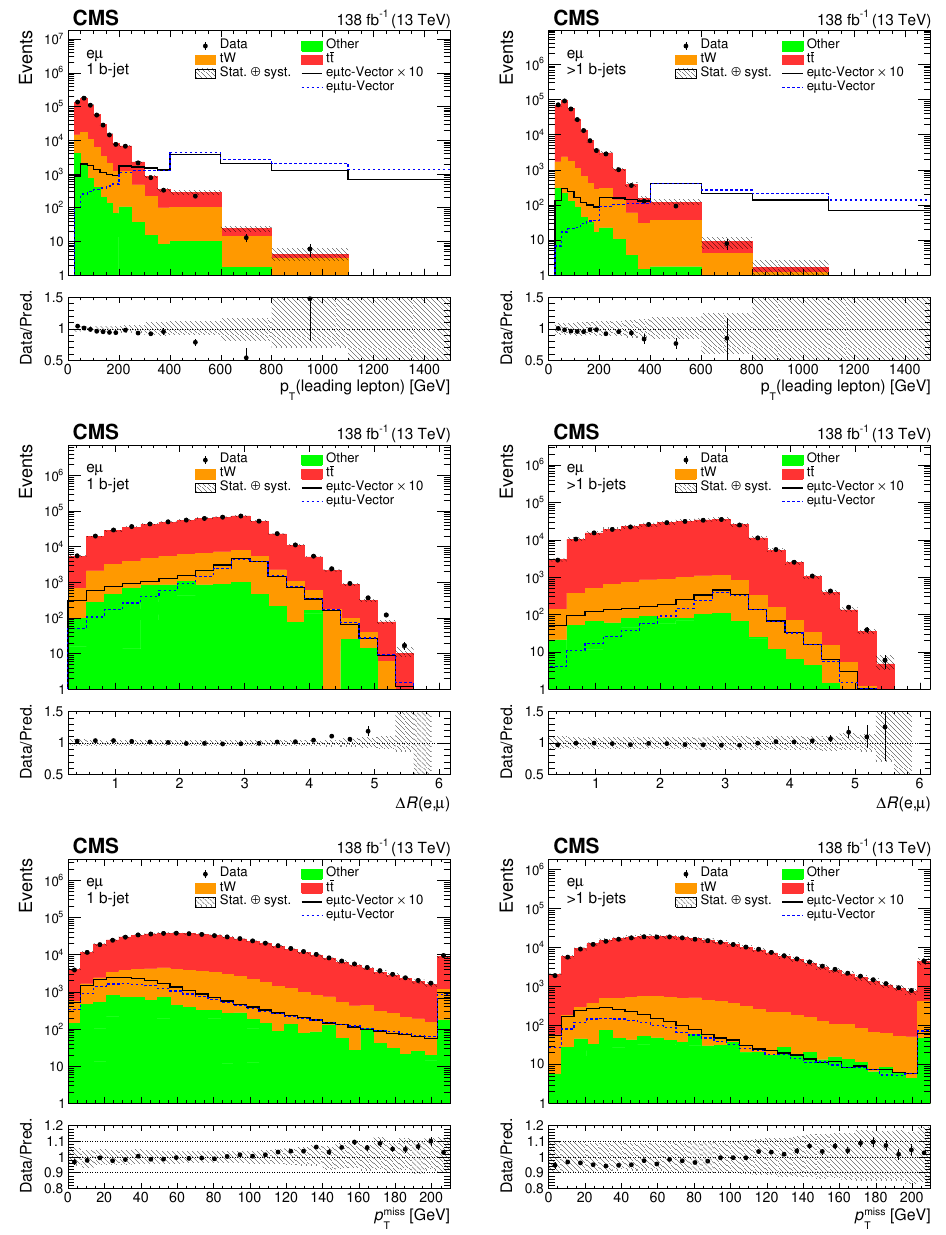
(upper row), ∆ R (e , m ) (middle row), and Figure 2 . The distributions of the leading lepton p T (lower row) are shown for data (points) and simulation (histograms). Events in the signal p miss T region (one b tagged jet) and tt control region (more than one b tagged jets) are shown in the left and right column, respectively. The hatched bands indicate the total uncertainty (statistical and systematic taken in quadrature) for the SM background predictions (cf. section 6). Overflow events are added to the last bin. Examples of the predicted signal contribution for the vector type CLFV interactions via e m tu and e m tc vertices are shown, assuming C / Λ 2 = 1 TeV − 2 . The signal x production- and decay-mode contributions are summed. The e m tc signal cross section is scaled up by a factor of 10 for improved